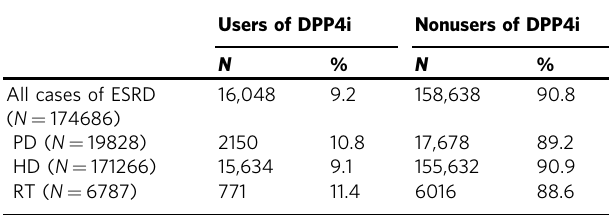
Table 1 Percentage of users and nonusers of DPP4i among diabetic ESRD patients with different dialysis modalities. Table 2 Comparison of rate of PD transition to HD between